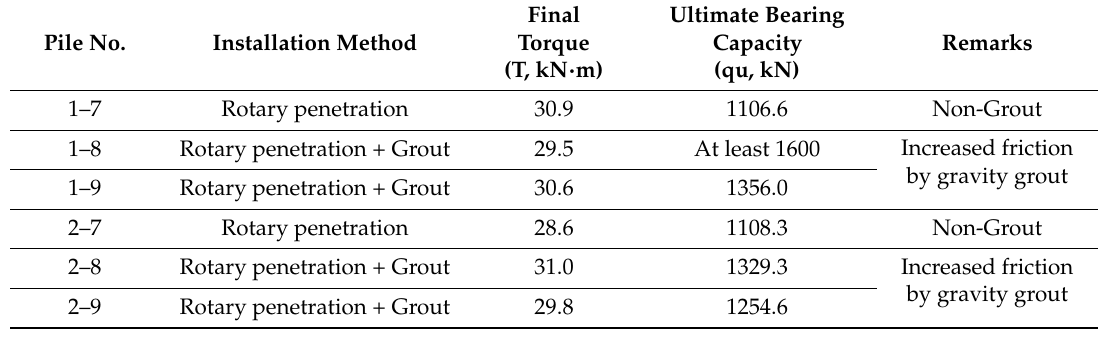
Table 11. Measured torque (T) and ultimate bearing capacity (qu).